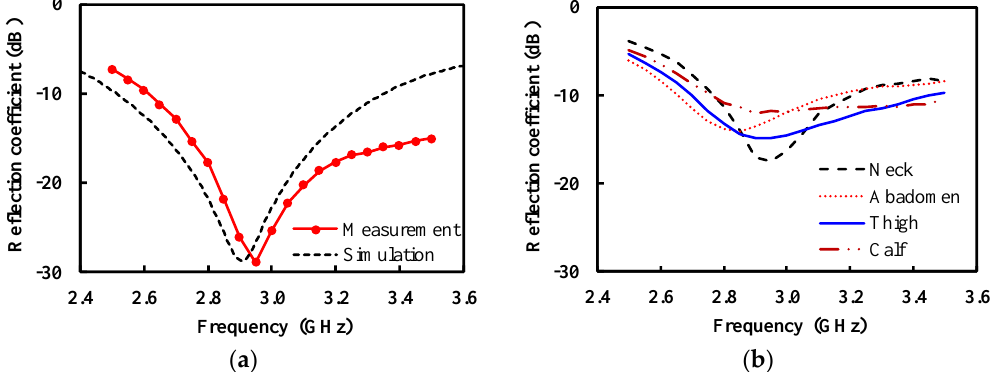
Figure 10. Measurement of the antenna on the human body ( a ) head; ( b ) various human parts (neck, abdomen, thigh, and calf).